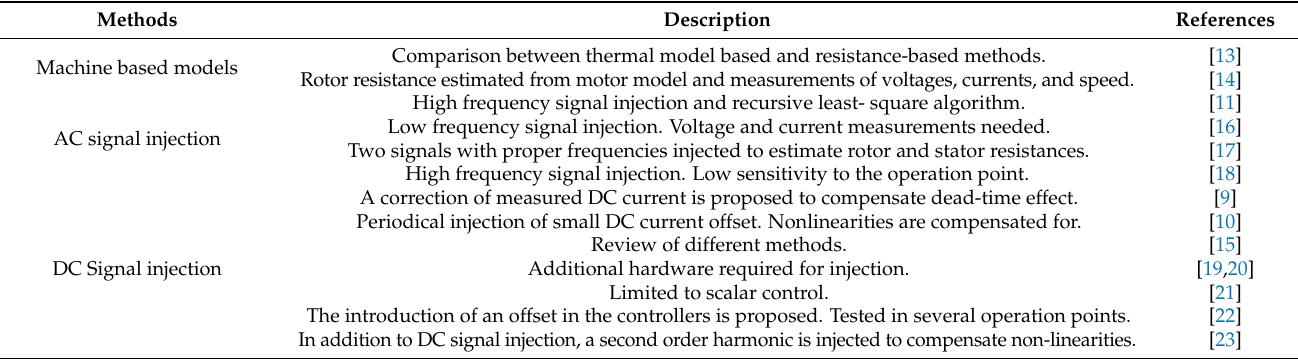
Table 1. Methods to estimate the temperature from